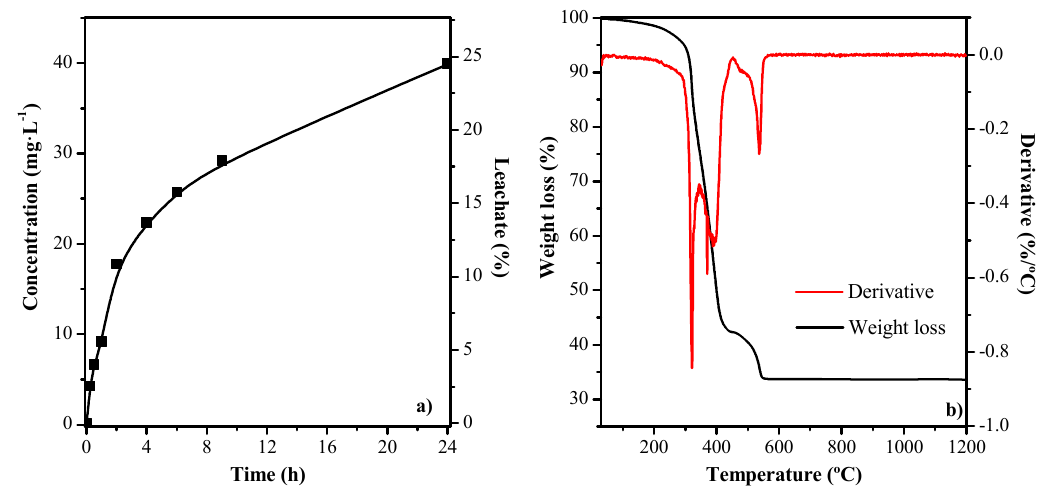
Figure 1. ( a ) Time course of linker concentration and leachate percentage in water from NH 2 - MIL-125(Ti) upon contact time; ( b ) thermogravimetric analysis in air of NH 2 -MIL-125(Ti) and its corresponding